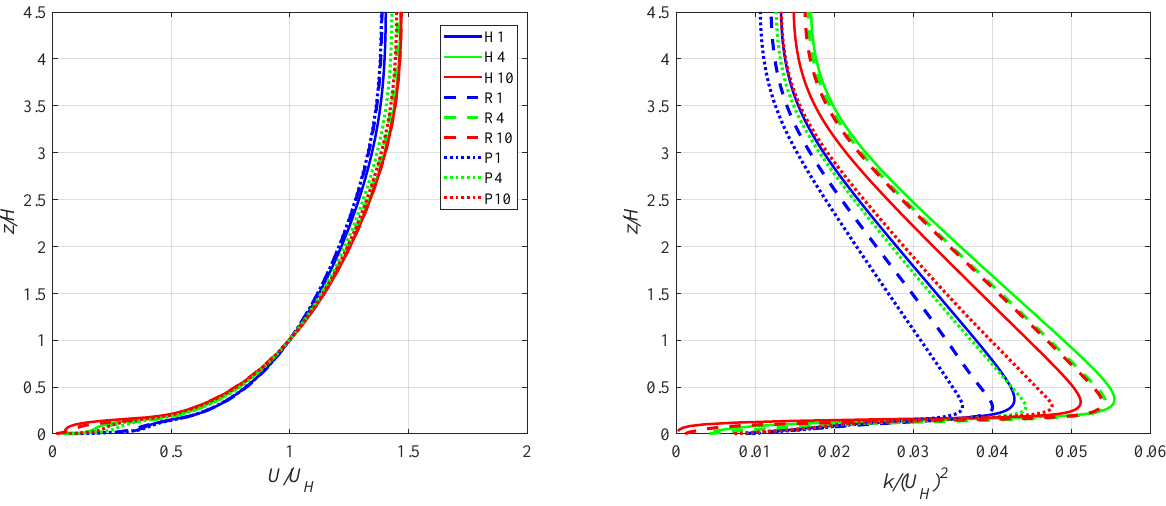
Figure 16. Mean velocity ( left ), and TKE ( right ) profiles for all cases. Comparing the TKE at different heterogeneity levels for respective LAI, Figure 16 (right) shows that above the canopy, for LAI = 0.43, the homogeneous forests produced the highest TKE, the real forests generated a lower TKE, and the patched forest produced the lowest TKE. A similar observation is made in forests with LAI = 1.7 but with a relatively small difference between the TKE production in homogeneous and real forests. TKE production than the homogeneous forests with about 6% increase at the hub